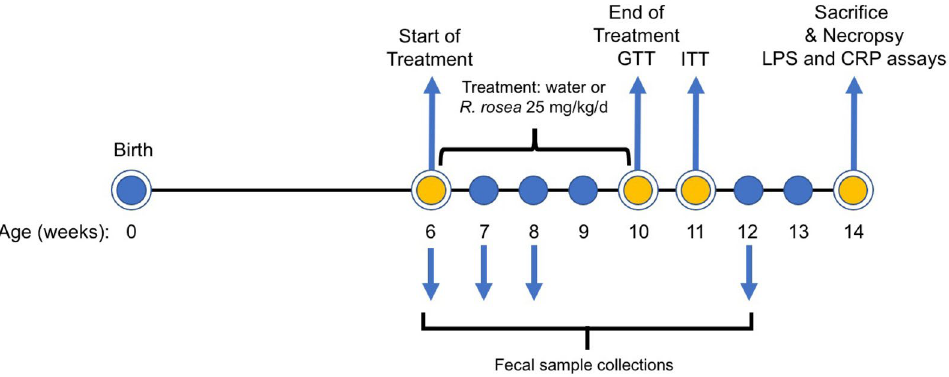
Figure 1. Timeline and experimental design. Cohorts of db/db mice were treated beginning at 6 weeks of age with R. rosea extract (25 mg/kg daily by oral gavage) or with water for a total of 4 weeks. A glucose tolerance test (GTT) was administered at the end of treatment (week 10), and an insulin tolerance test (ITT) administered 1 week later (week 11). Fecal samples were collected for microbiome analysis before treatment at week 6, and subsequently at weeks 7, 8 and